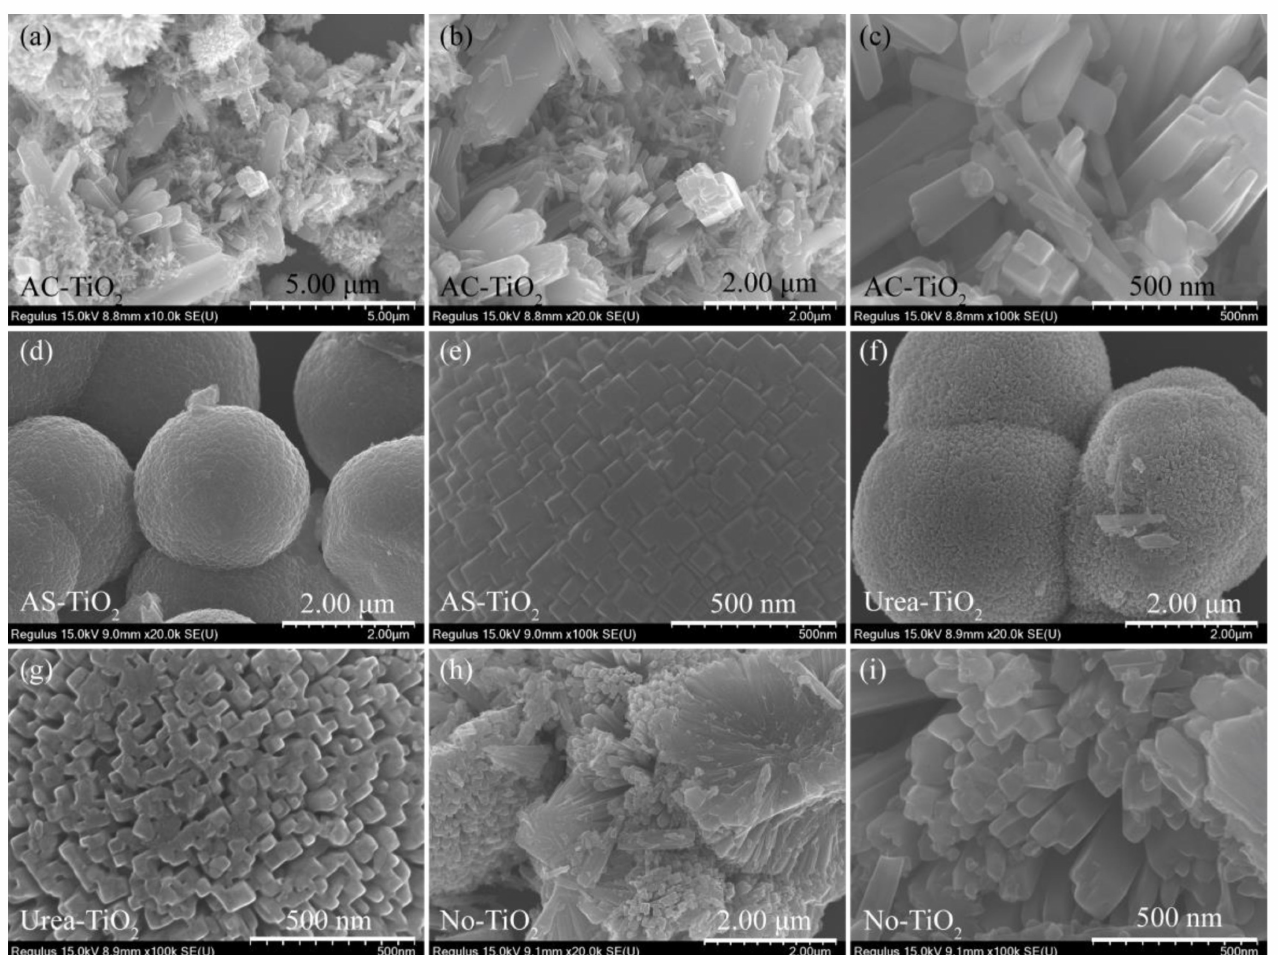
Figure 2. Different magnifications of FESEM images of the ( a – c ) AC-TiO 2 ; ( d , e ) AS-TiO 2 ; ( f , g ) urea-TiO 2 ; ( h , i ) No-TiO 2 samples in the presence and absence of shape-controlling agents.